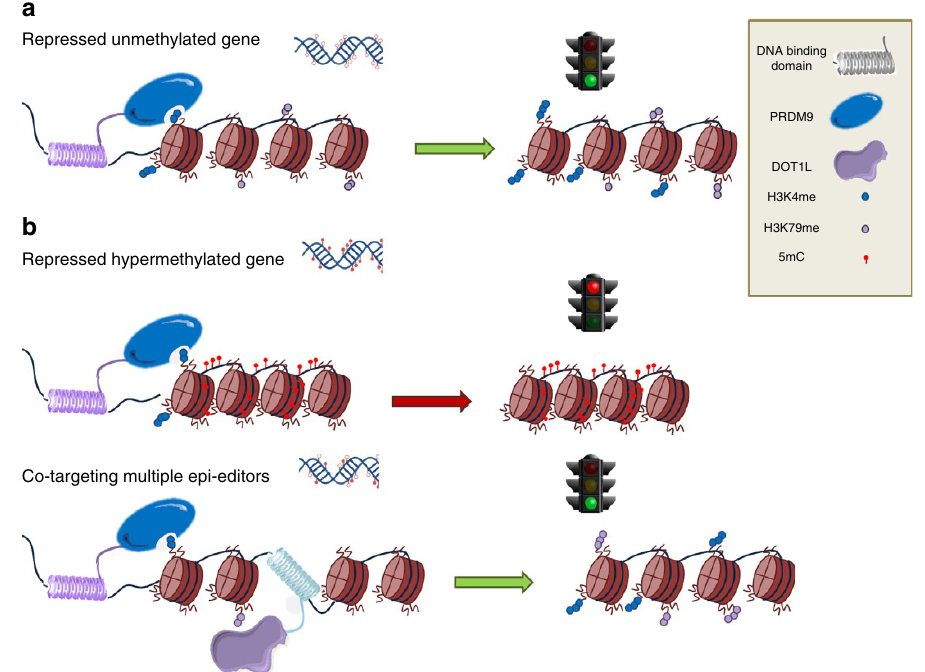
Figure 7 | Model of epigenome editing to achieve stable gene reactivation depending on the chromatin microenvironment ( a ) Stable gene reactivation is achieved by targeting H3K4 methyltransferases to a non-hypermethylated locus. ( b ) Gene reactivation is not achieved by targeting H3K4 methyltransferases to a hypermethylated locus. ( c ) Co-targeting different epigenetic editors to achieve sustained reactivation at hypermethylated